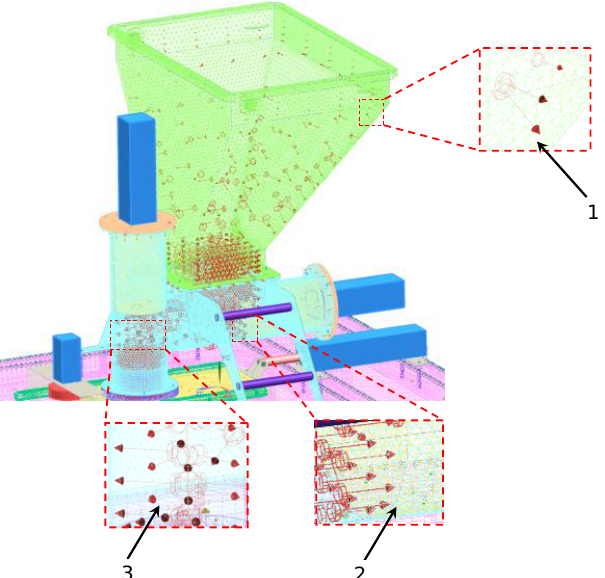
Figure 9. Load application site: charge pressure on the side walls of the technological tank, on the side wall of the piston, and on the side walls of the dispensers. 1. Pressure forces of the vegetable mix on the side walls of the technological tank, 2. Pressure forces of the vegetable mix on the side wall of the piston, 3. Pressure forces of the vegetable mix on the side walls of the dispensers